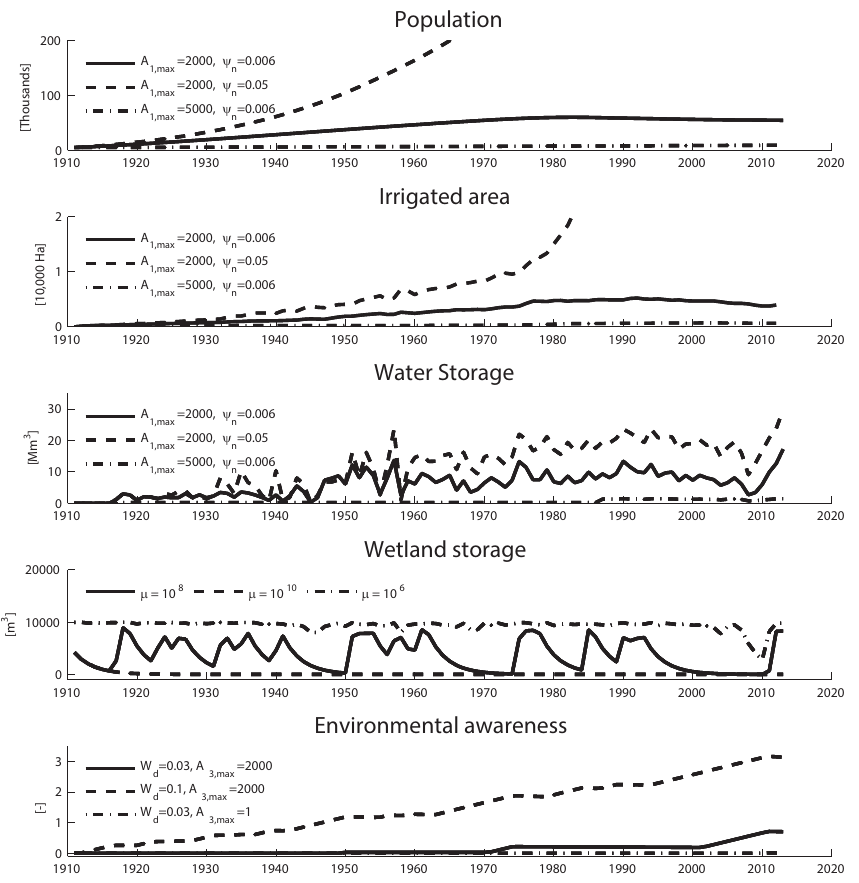
Figure 14. Three model modes for population, irrigated area, water storage, wetland storage and environmental awareness: realistic (solid), increasing (dashed) and declining